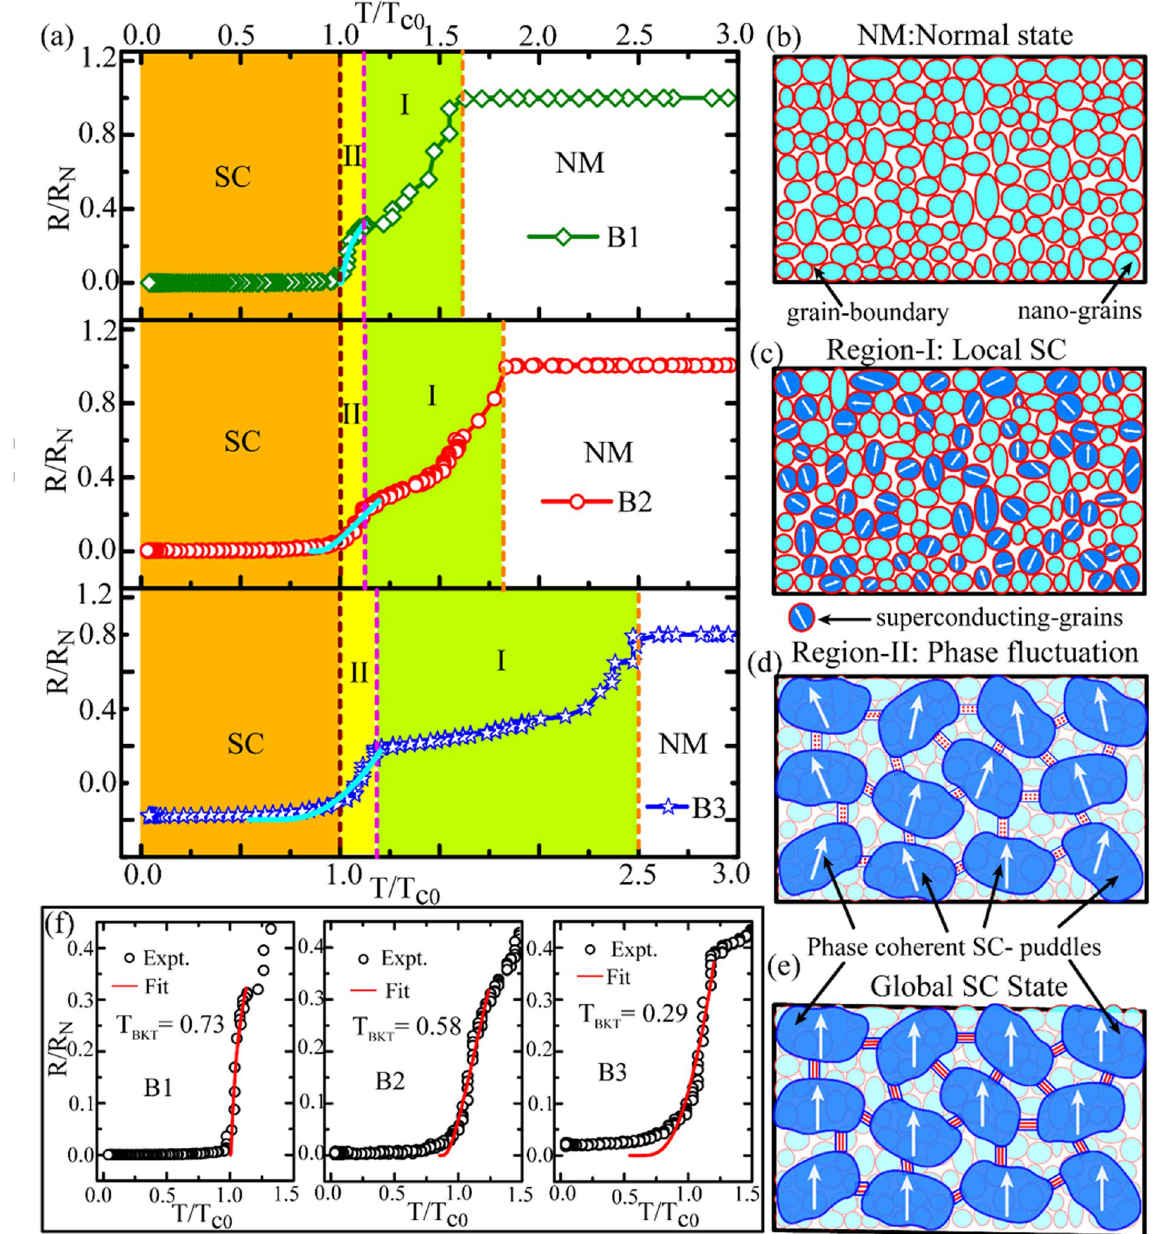
Figure 7. Representation of NM-SC phase transition of Nb 2 N thin films pictographically by using R(T) characteristics and the granular structure of the samples. ( a ) Normalized resistance in reduced temperature scale separately for all the three nitride samples. The colored shaded regions bounded by the dotted vertical lines represent different stages of the phase transition and the stages are illustrated schematically through ( b ) to ( e ). Illustration of the granular films in normal state ( b ), establishment of local superconductivity in individual grains for the transition region-I ( c ), formation of superconducting puddle by combining phase coherent superconducting nano-grains in region-II ( d ), and finally the establishment of global coherence among the puddles to achieve the superconducting state ( e ). The solid cyan curves shown in ( a ) for the resistive transition in region-II represent the BKT transition using Halperin-Nelson equation which provides the BKT transition temperature T BKT and the fittings for individual samples are shown in ( f ) which selectively displays the fitting regions for all the three nitride samples. The details are explained in the